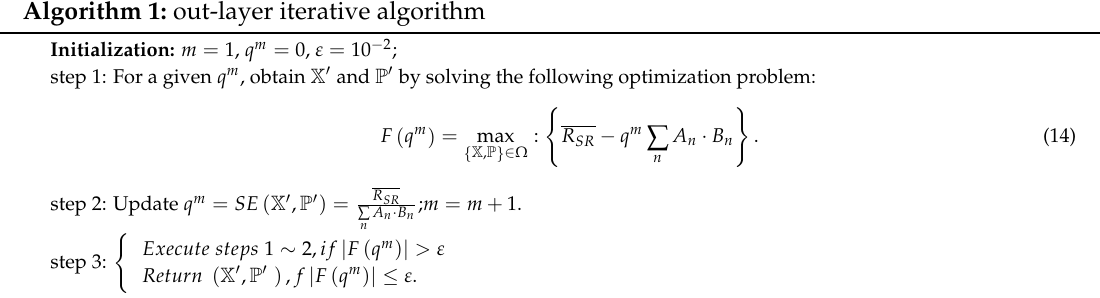
Algorithm 1: out-layer iterative